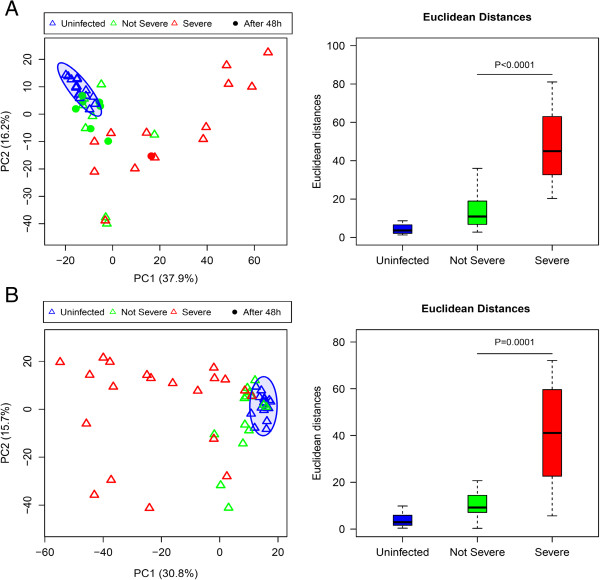
Responses to septic plasma measured in a PMN reporter assay for additional sets of subjects. Plasma samples from two additional sets of subjects were used in new sets of experiments: A and B corresponding to experiments II and III, respectively. PMNs used in both experiments were obtained from the same donor (donor H2) who had also participated in experiment I. Transcripts passing filter criteria of 2 fold-change and 100 difference in intensity (2FC100DIF) were used. PCA plots (left panels) were generated as described earlier. Colors and symbols indicate sample class and disease severity: red triangle, severe sepsis; green triangle, not severe sepsis; blue triangle, uninfected; and closed circle, plasma collected >48 h after admission. Numbers in parenthesis indicate percentage of variance. Box plots (right panels) show Euclidean distances calculated for each sample from the center of ellipses corresponding to responses to plasma from uninfected controls. P-values were derived from a Mann-Whitney U-test.